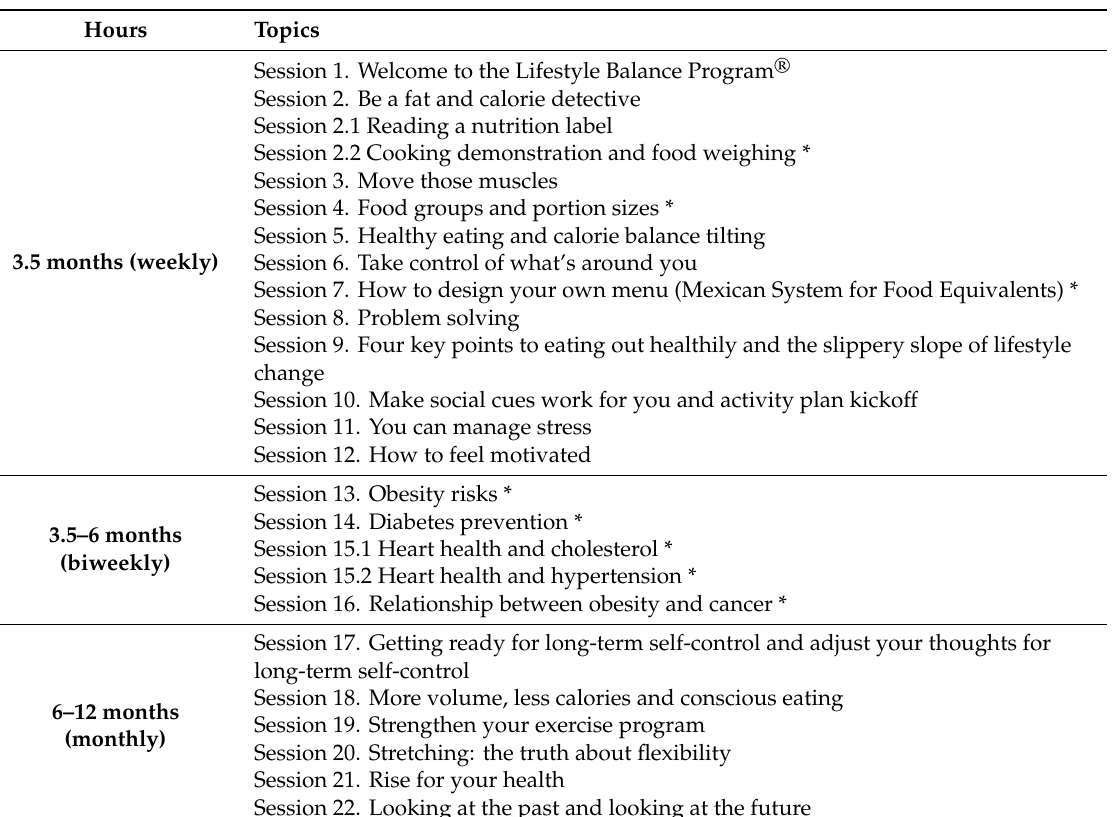
Table 1. Adaptation of the Diabetes Prevention Program (DPP) protocol “Group Lifestyle Balance